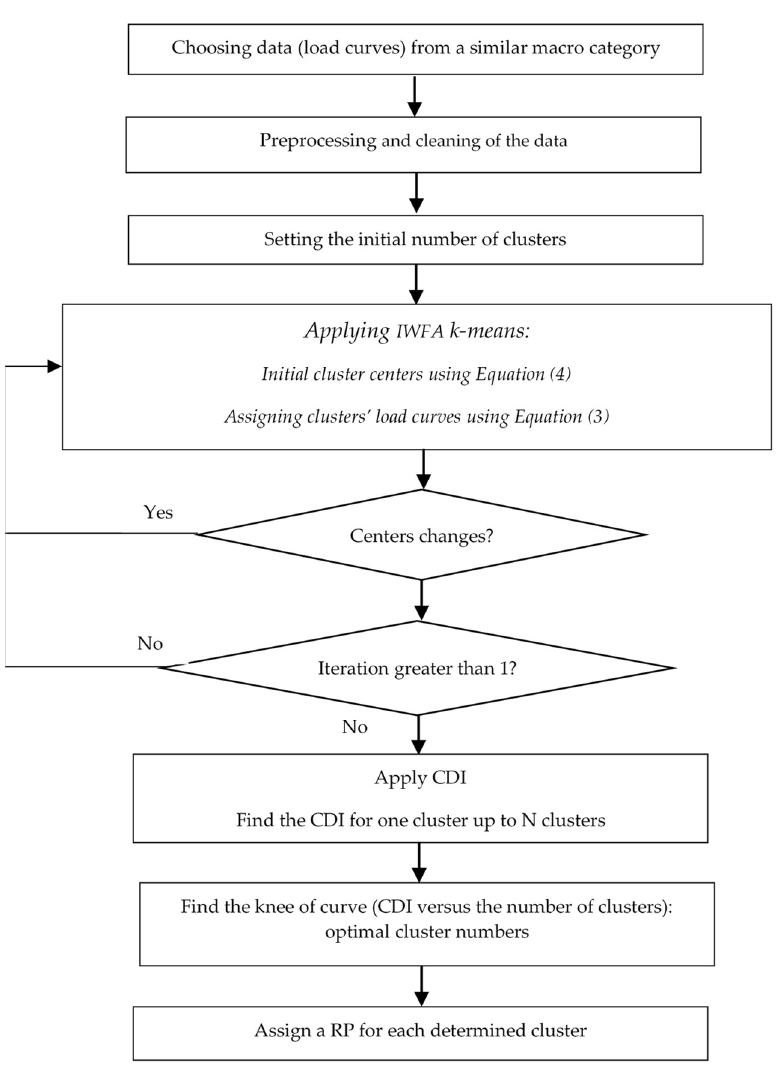
Figure 2. The procedure of the proposed improved WFA k-means.